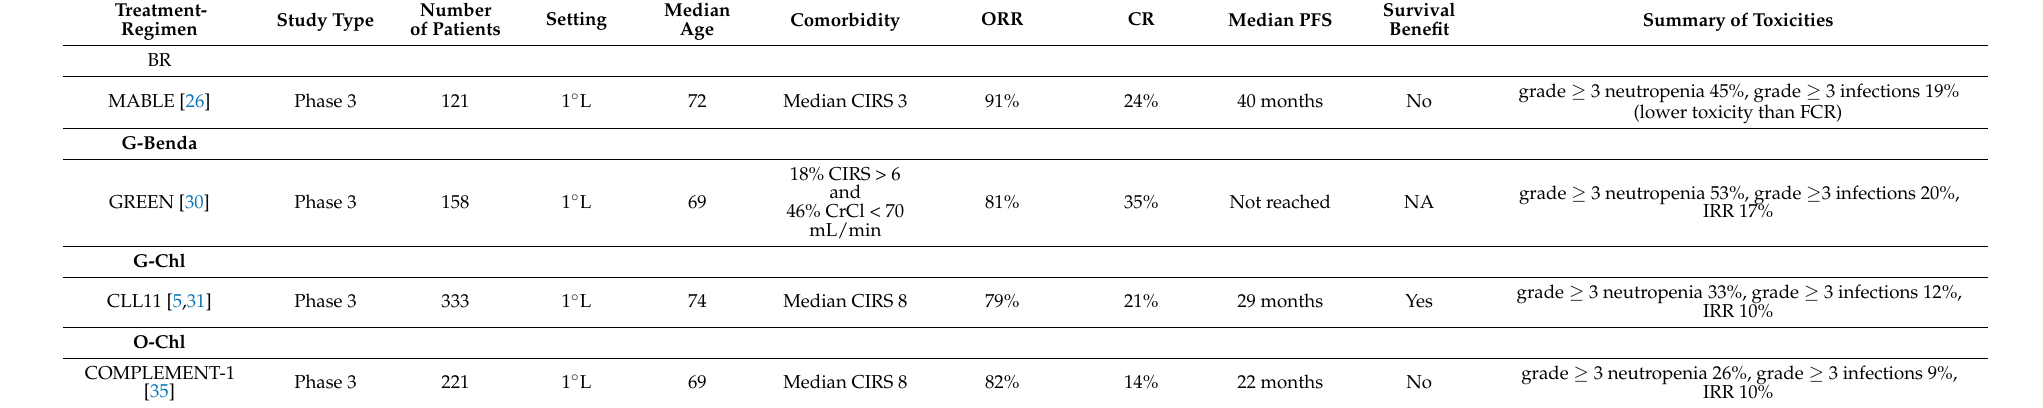
Table 1. Currently available evidence from trials of chemoimmunotherapy in elderly patients with